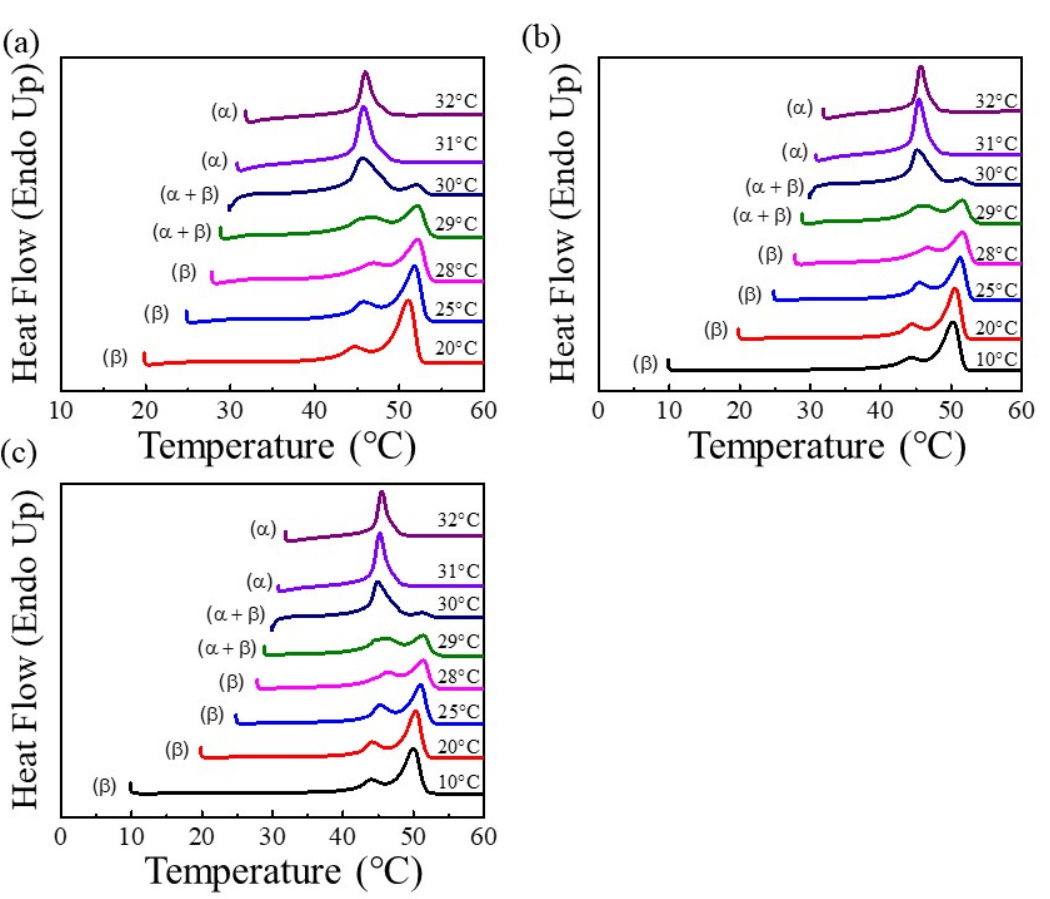
Figure 8. DSC heating curves of ( a ) 1 wt% g-PBAT-90/m-LDH, ( b ) 3 wt% g-PBAT-90/m-LDH, and ( c ) 5 wt% g-PBAT-90/m-LDH nanocomposites, crystallized at different temperatures, as indicated on traces.